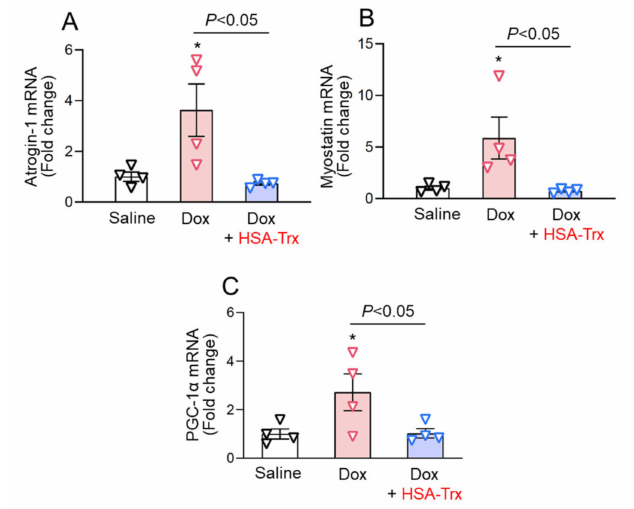
Figure 3. Effect of HSA-Trx on myocardial atrophy-related genes in the heart of Dox-induced cardiomyopathy model mice. ( A ) Atrogin-1, ( B ) myostatin and ( C ) PGC-1a mRNA expression in the heart at 4 weeks after the first injection of Dox were determined by real-time qPCR. PBS or HSA-Trx (400 nmol/kg) was administered i.v. three times a week from 2 weeks after the first injection of Dox. Results are the means ± S.E. ( n = 4). * p < 0.05 compared with the saline injection group (normal